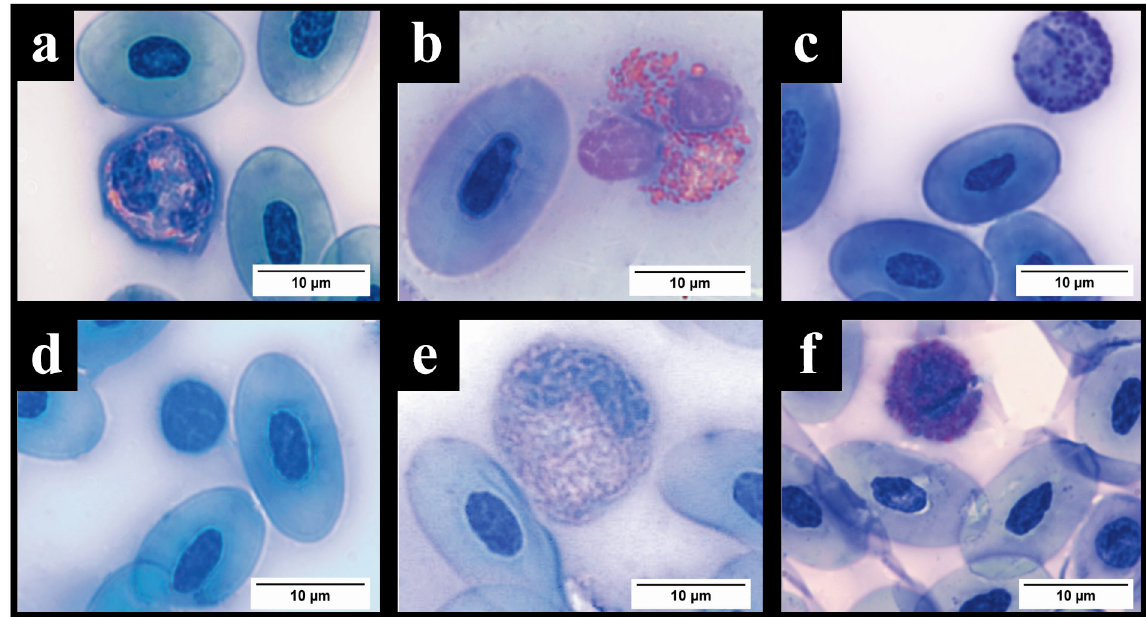
Figure 1 - Selected photographs of six types of leukocytes found in Liolaemus sarmientoi . Granulocyte cells: heterophil ( a ), eosinophil ( b ), and basophil ( c ); mononuclear cells: lymphocyte ( d ) and monocyte ( e ); and azurophil ( f ) are indicated. May- Grünwald Giemsa stain. Bars = 10